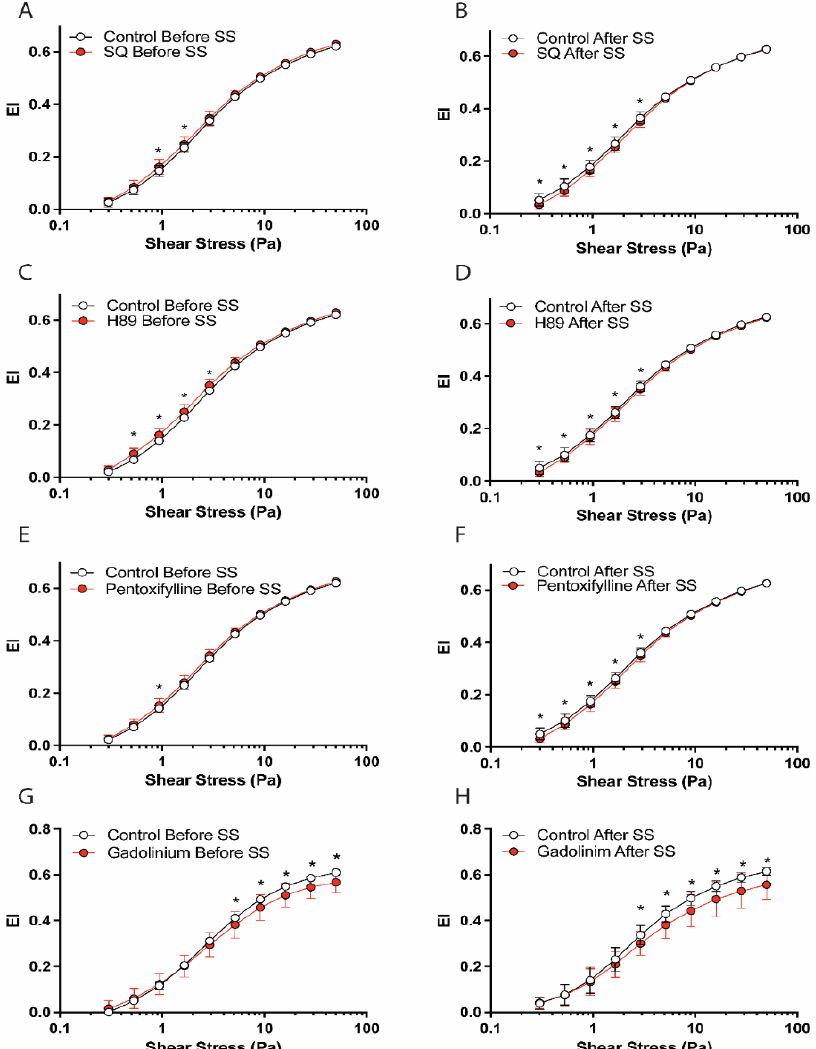
Figure 1. EI–SS curves before and after 5 Pa SS exposure. The graphs demonstrate deformability changes by SQ22536 ( A , B ), H89 ( C , D ), pentoxifylline ( E , F ), and gadolinium ( G , H ) compared to the control. Panels ( A , C , E , G) show deformability curves before SS exposure and panels ( B , D , F , H) show deformability curves after SS exposure. Data are represented as means ± SD, n = 12, * p < 0.05.